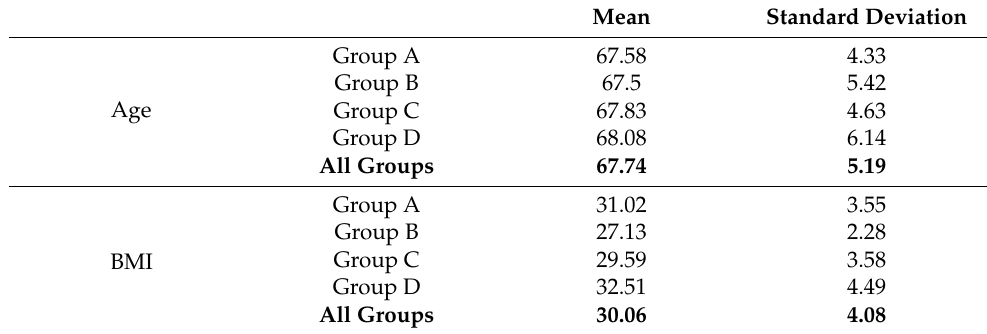
Table 1. Age and BMI divided by groups.